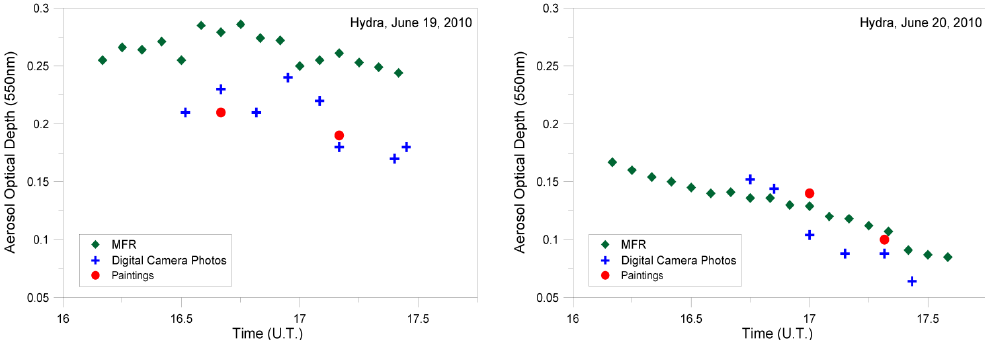
Fig. 9. The AOD values from the MFR measurements, the estimations from the digital images and the calculations from R/G ratios of the Hydra sunset paintings for 19 June (left panel, higher aerosol content) and on the 20 June 2010 (right panel, lower aerosol content).